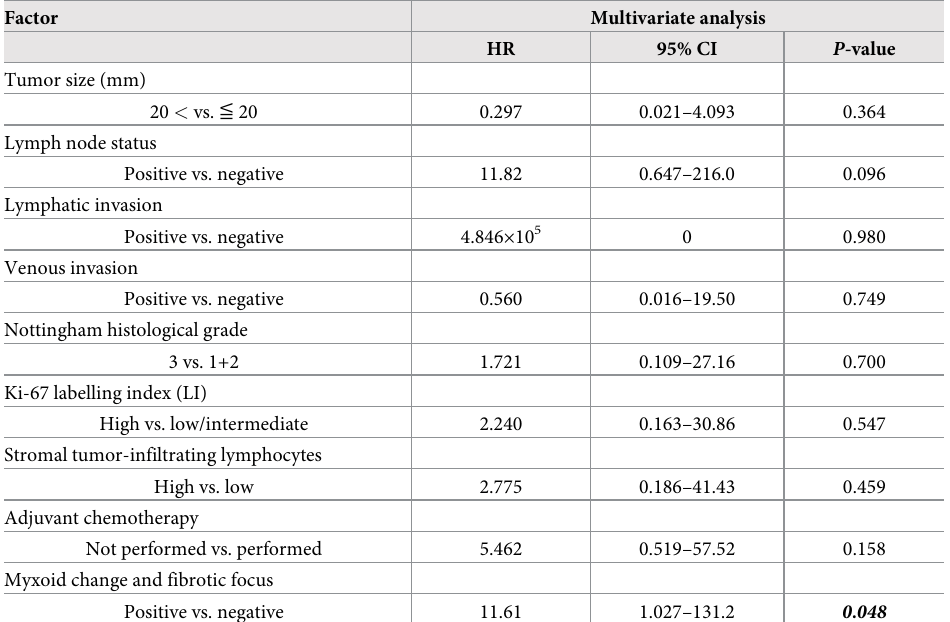
Table 5. Multivariate analysis of relapse-free